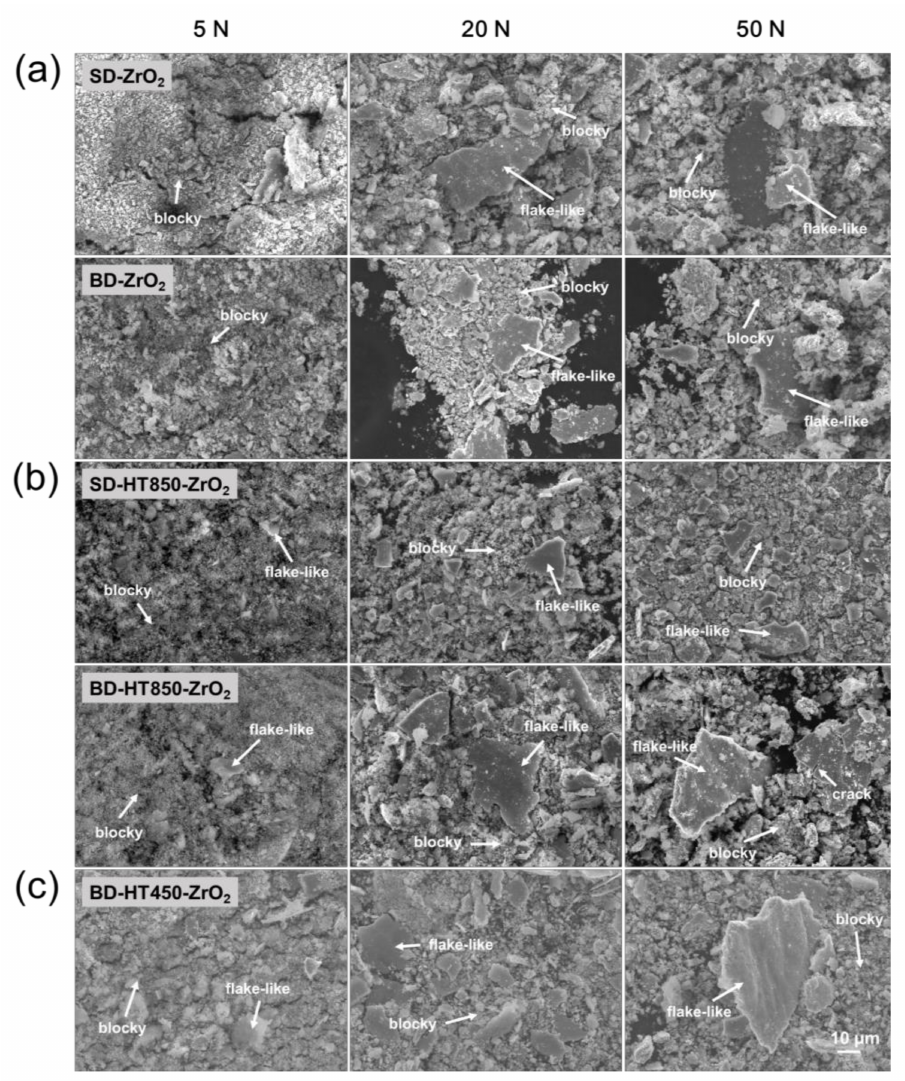
Figure 11. SEM images of the debris of maraging steel worn against ZrO 2 balls: ( a ) as-built, ( b ) HT850 and ( c ) HT450 heat-treated